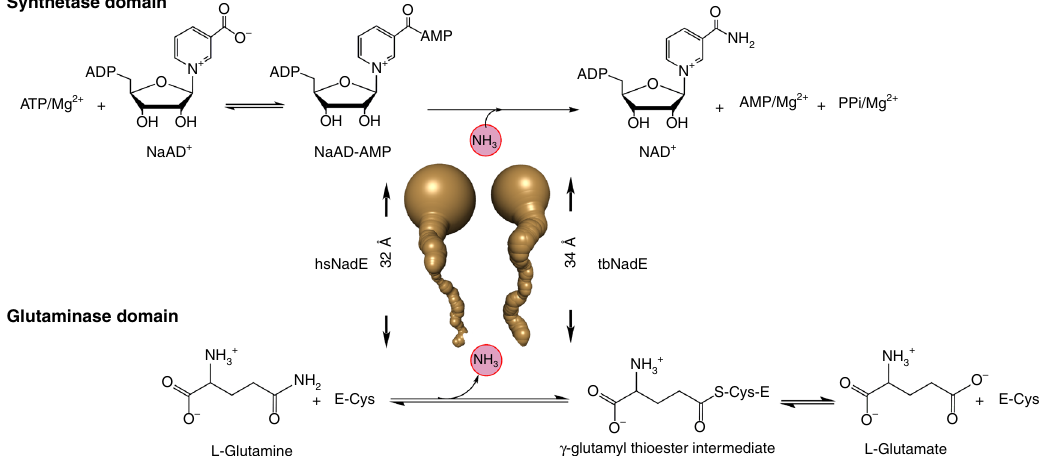
Fig. 1 Reaction catalyzed by glutamine-dependent NAD + synthetase. Ammonia tunnels of hsNadE and tbNadE shown in gold indicate the ammonia transfer from the glutaminase to the synthetase active